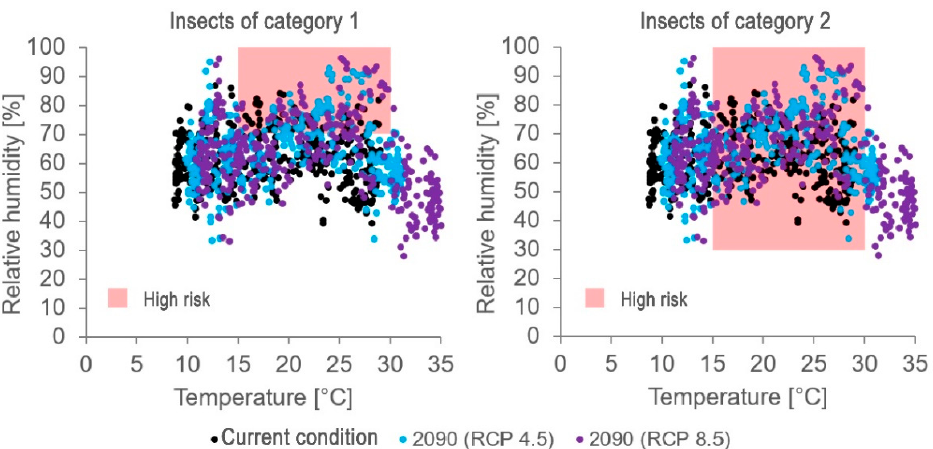
Figure 15. Distribution of daily mean T and RH for the different scenarios analysed, for the fa ‐ vourable conditions for insect growth. The picture on the left shows the optimal conditions for insects belonging to Category 1 and the picture on the right those for Category 2 . belonging to Category 1 and the picture on the ( right ) those for Category 2